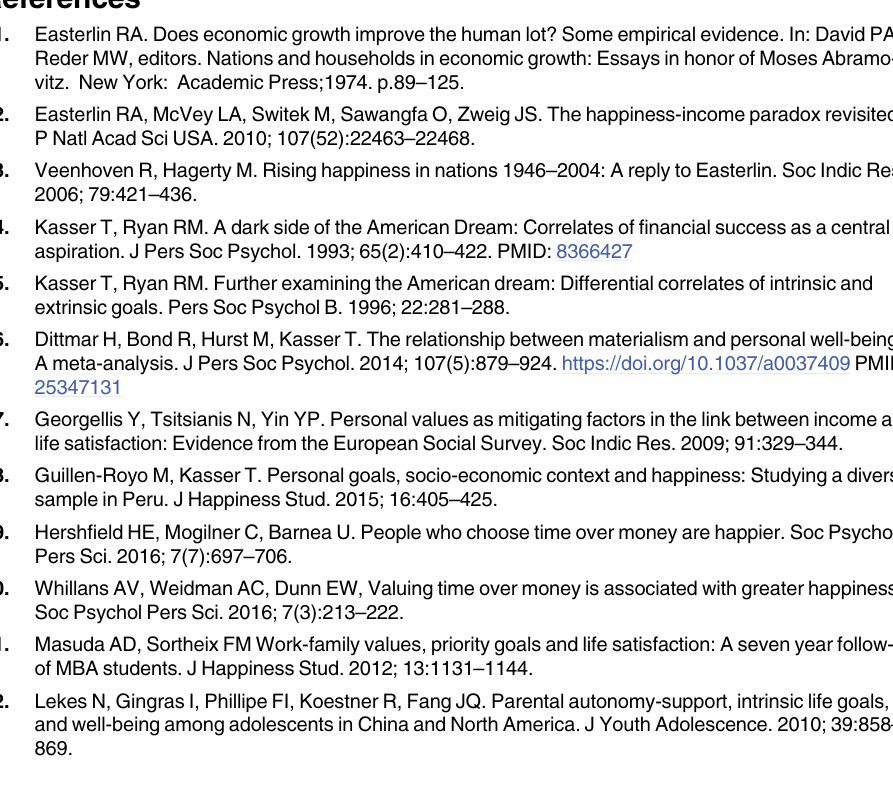
S1 Table. Poisson regression analyses with robust error variances including prioritizing leisure as a single category (relative risks). S2 Table. Multiple regression analyses examining associations between personal values on life domains and happiness. S3 Table. Poisson regression analyses with robust error variances including extrinsic achievements as a referent category (relative